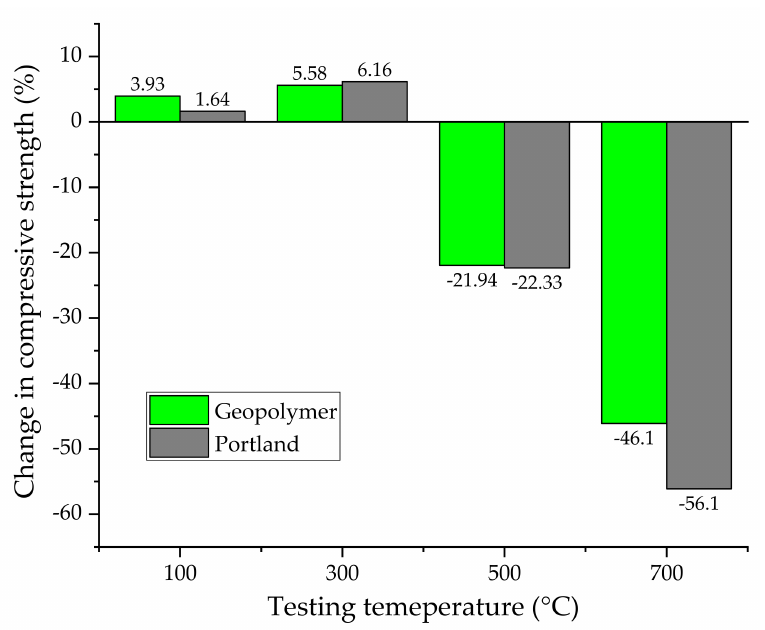
Figure 17. Compressive strength after temperature exposure in Ferrochrome slag based geopolymer and Portland concretes